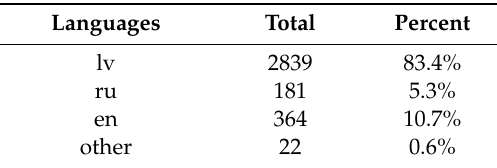
Table A31. Primary languages (lv).